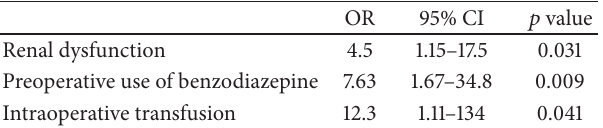
Table 3: Factors associated with the development of delirium in the intensive care unit after elective endovascular aortic